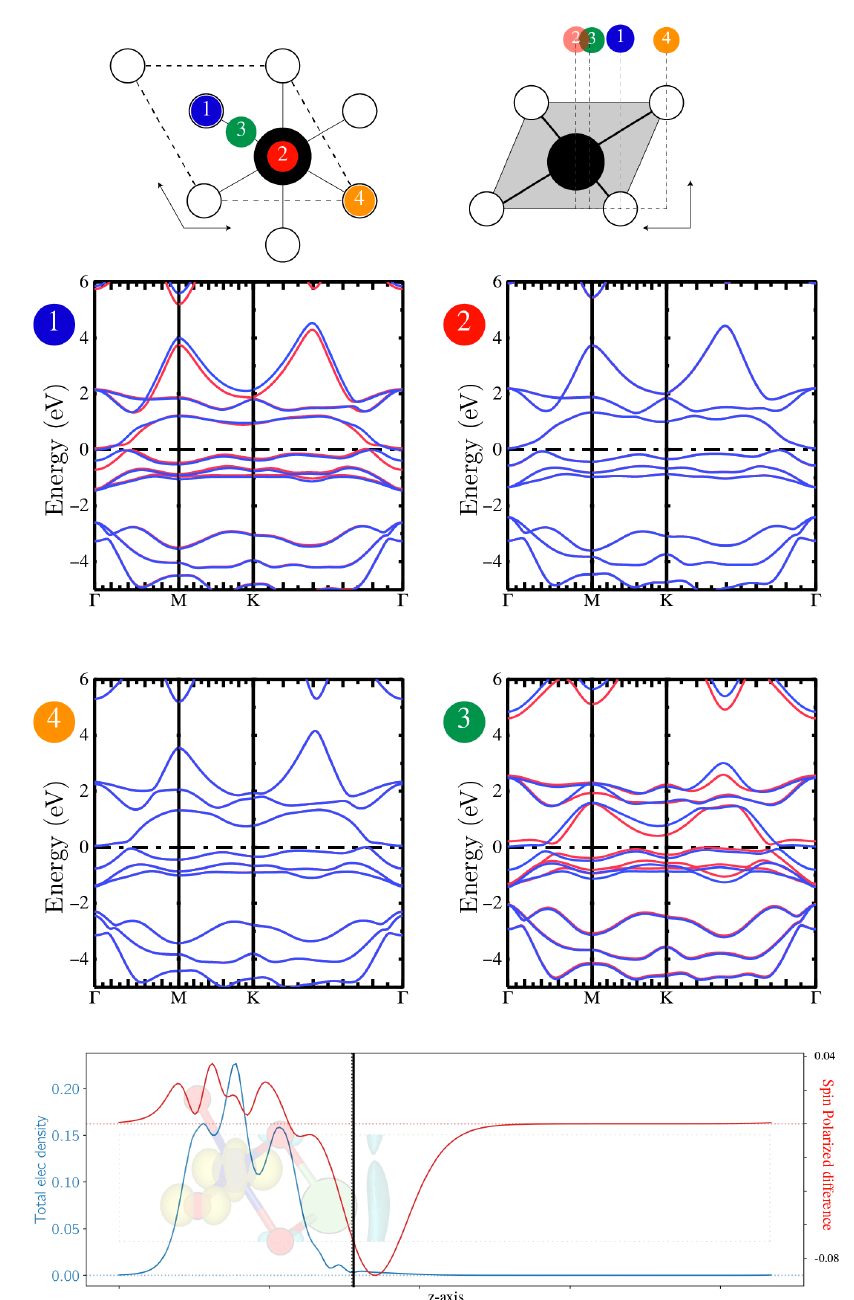
Figure 5: (top) top and side view of all 4 symmetric positions of Li on top of 2D CoO lattice. (middle) Spin polarized GGA band structures for the corresponding 2 structures. (bottom) Total electron density (blue) integrated along in-plane axis and spin difference = n ↓ − n ↑ (red). Black line shows the real space limit for integrating the surface charge density .